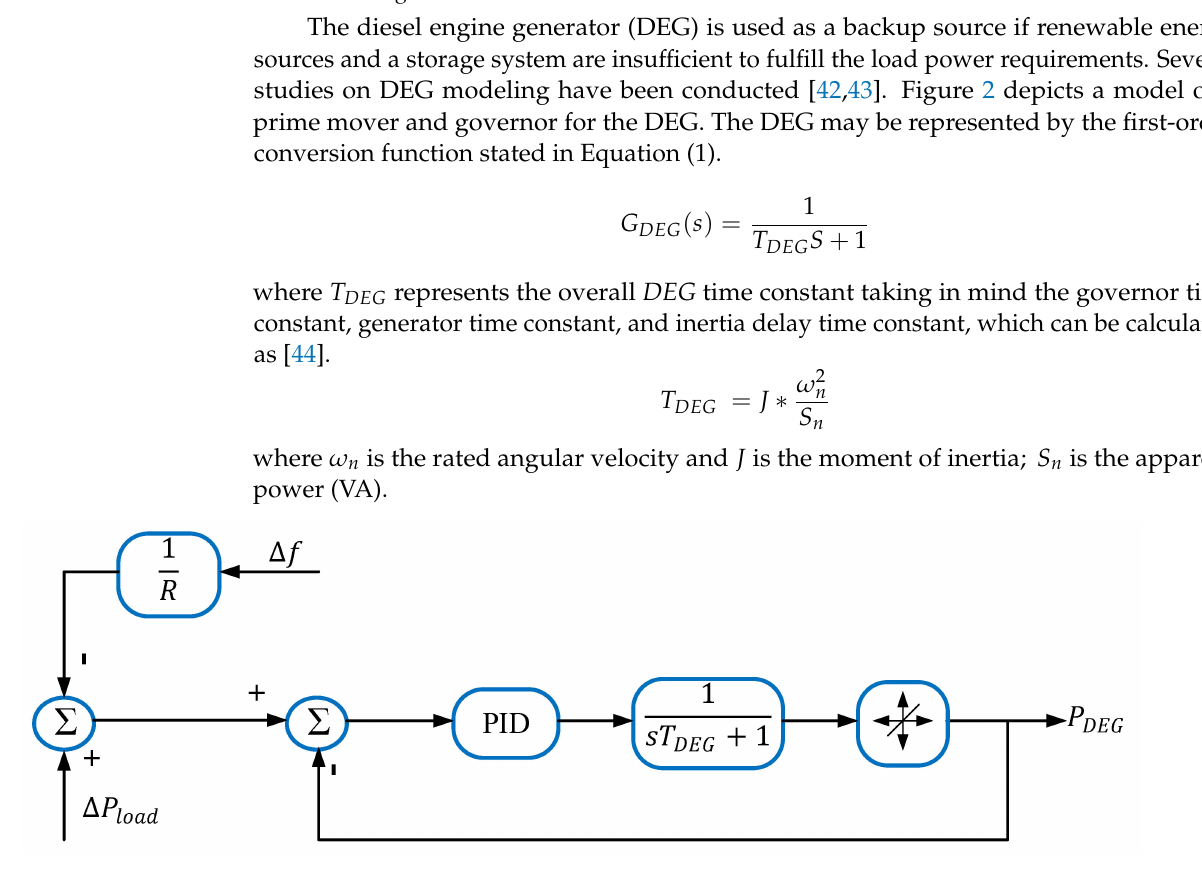
Figure 2. The model of the prime